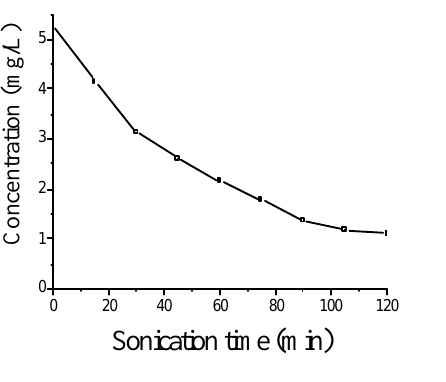
Figure 2. Concentration-sonication time Figure 3. Degradation kinetics of methyl violet. profiles of methyl